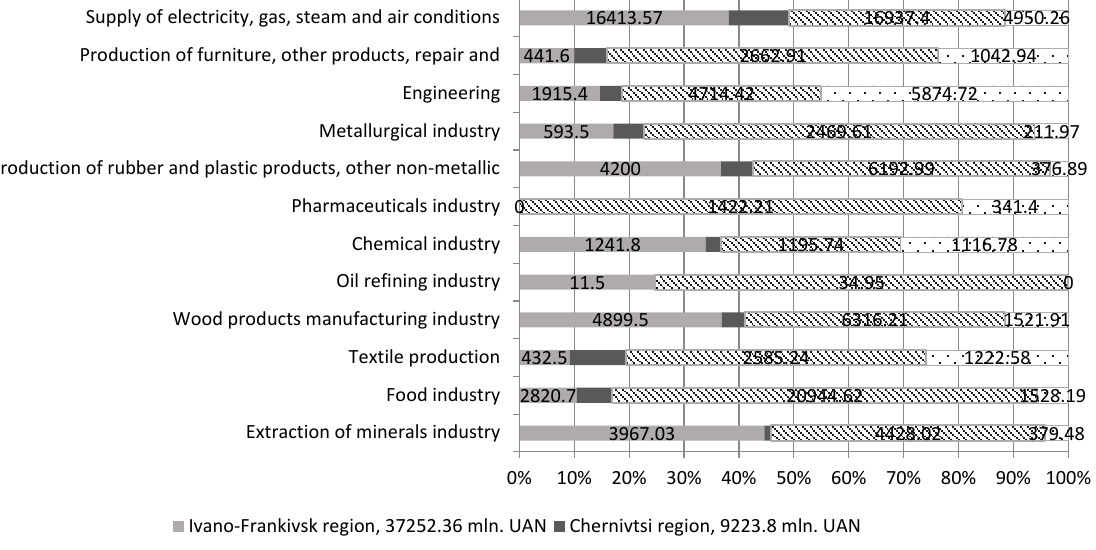
Figure 1. Growth areas of the Carpathian economic region determined by the highest performance of the industrial sales volumes by business profile for